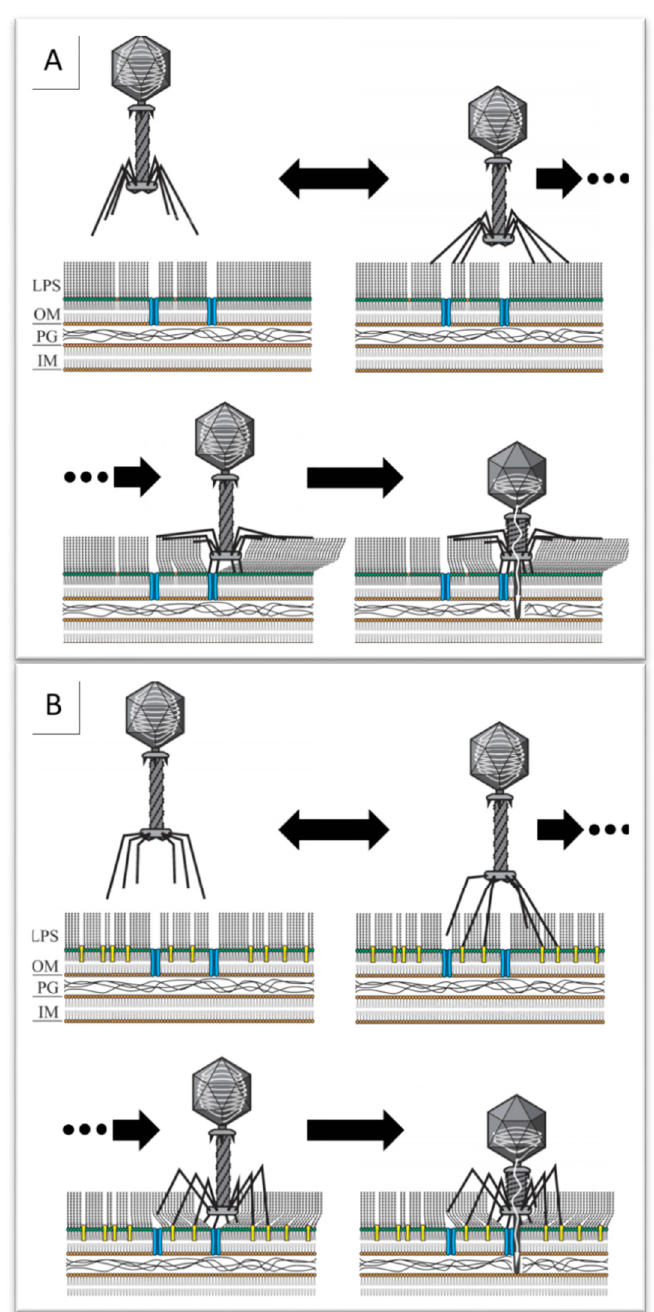
Figure 5. Model of the O antigen-producing host infection by RB49-like phages. ( A ) The LTFs of the phages RB49, Cognac49 or Whisky49 recognize O-polysaccharides of some strains (such as F5 or F17) triggering the baseplate rearrangement. The mechanical force of the deploying STF allows their C-terminal receptor binding domains to get through the O antigen layer to the receptors at the OM surface. ( B ) The LTFs of the phage Brandy49 are able to penetrate through the O antigen layer without binding to the OPS to recognize their receptors at the OM surface.